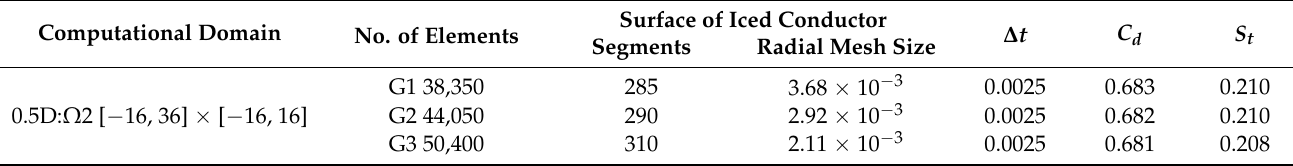
Table 2. Result comparisons of different mesh size.